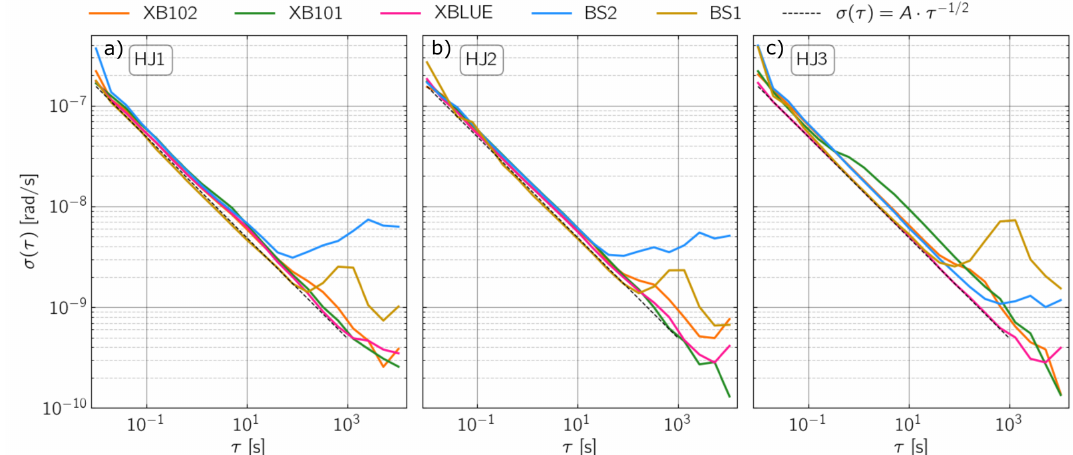
Figure 5. Allan Deviations for all sensors and all three components. ( a ) represents East, ( b ) North and ( c ) vertical components, respectively. The dashed line represents the white